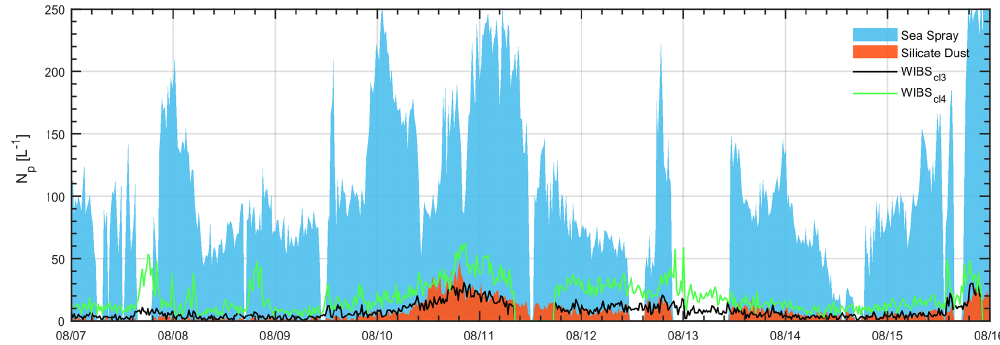
Figure 7. Time series of sea spray aerosol and silicate dust particle numbers concentrations determined by LAAP-ToF and WIBS-4A Clusters 3 and 4; 20min averages have been used here.